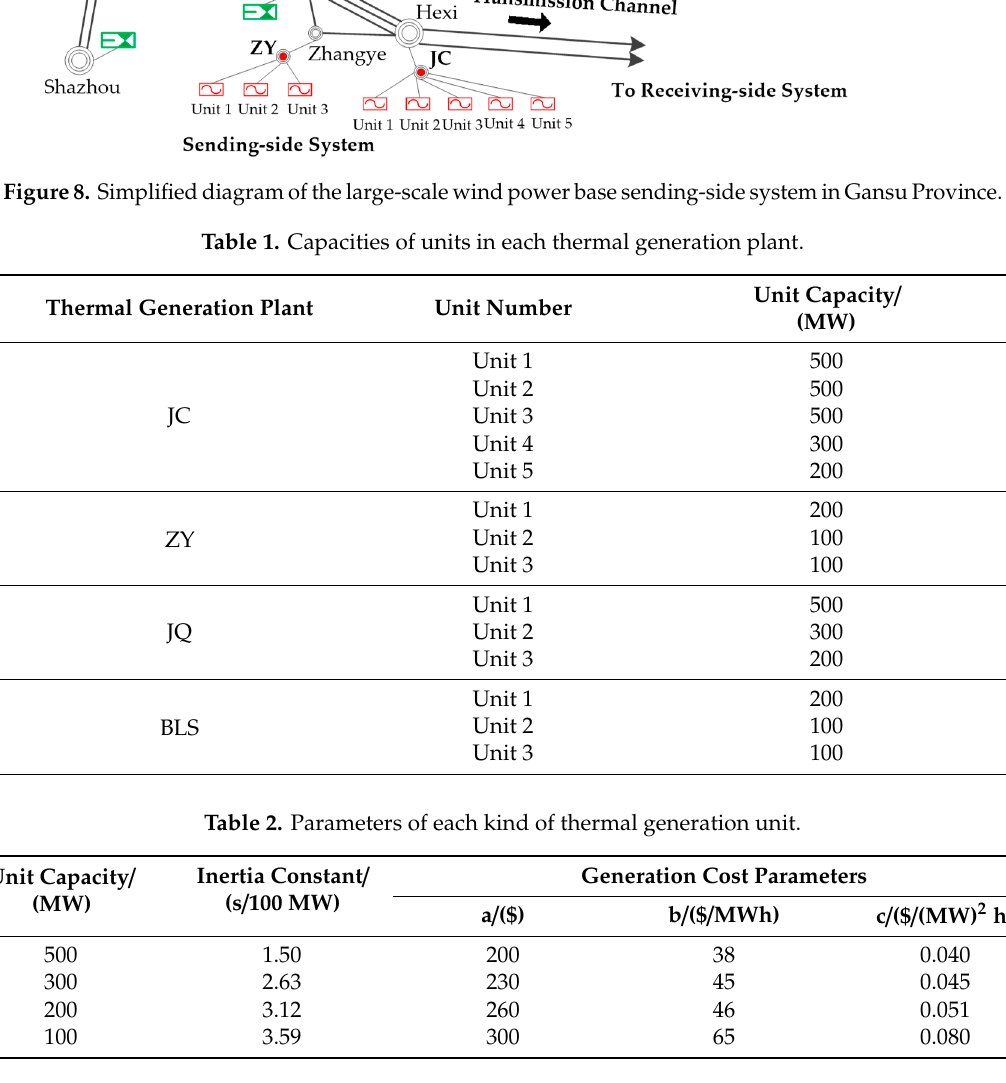
Table 3. Electrical distance